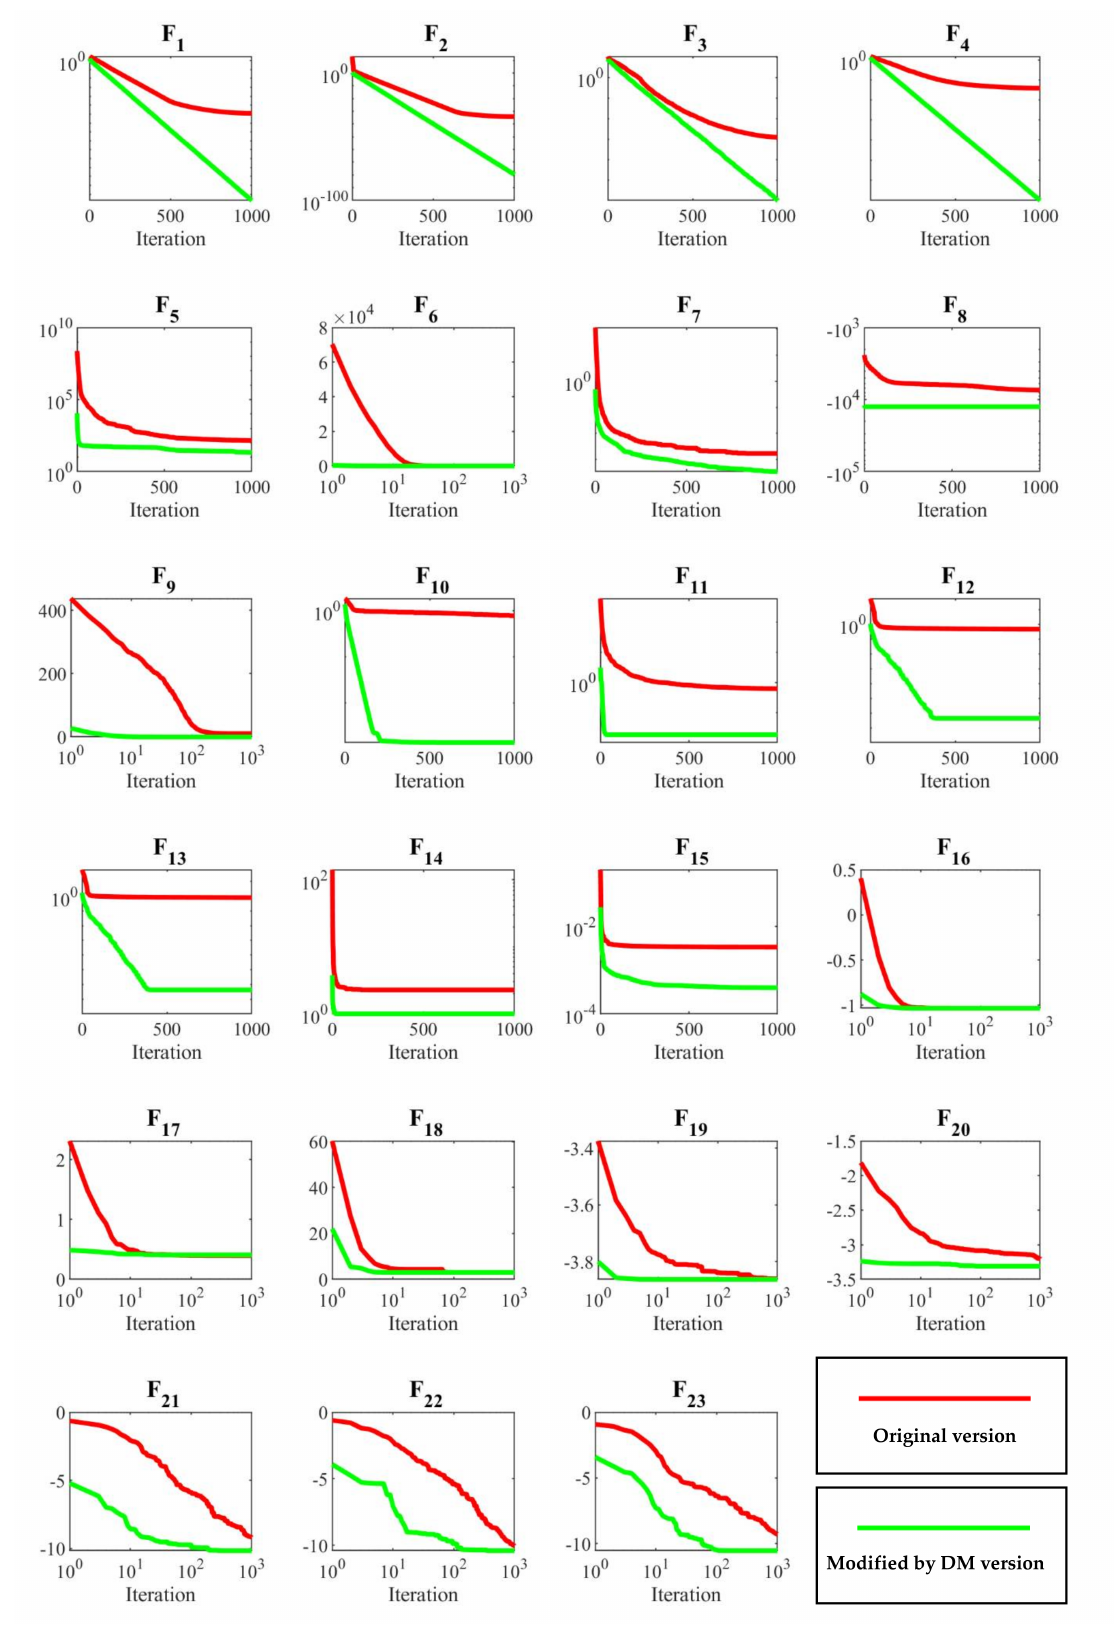
Figure 6. The convergence curves of TLBO for original and “modified by DM”